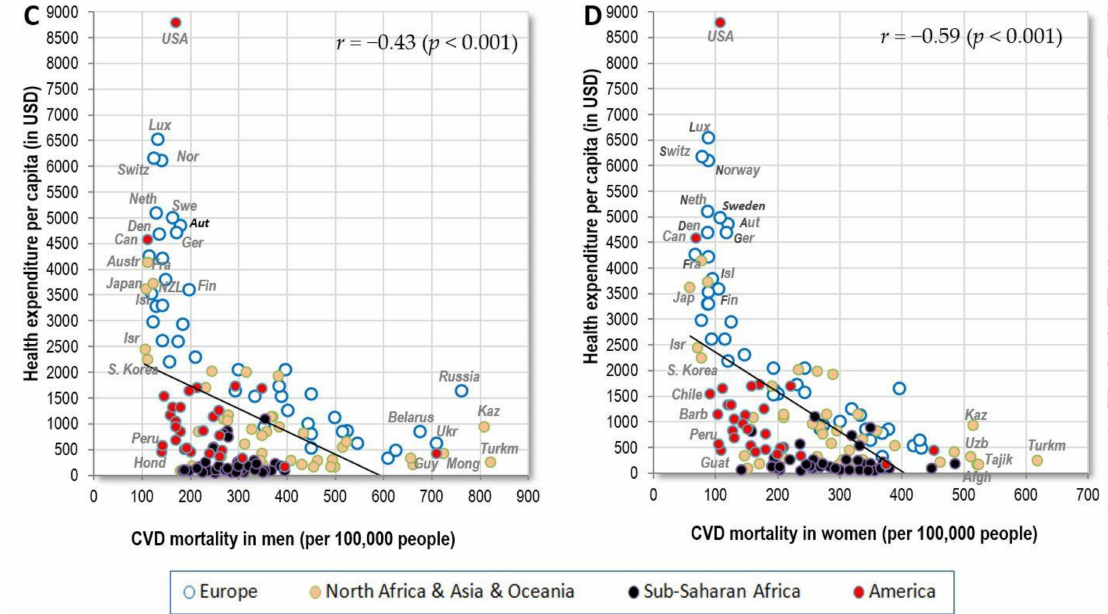
Figure 6. ( A ) Relationship between women’s CVD mortality (WHO, 2012) and the mean proportion of carbohydrate energy from cereals and starchy roots (% CC energy & % SRC energy) in the diet (FAOSTAT, 1993–2011); ( B ) Relationship between women’s CVD mortality (WHO, 2012) and the mean consumption of total fat and animal protein (g/day per capita; FAOSTAT, 1993–2011); ( C ) Relationship between men’s CVD mortality (WHO, 2012) and health expenditure per capita for 2012 (in USD; ( D ) Relationship between women’s CVD mortality (WHO, 2012) and health expenditure per capita for 2012 (in